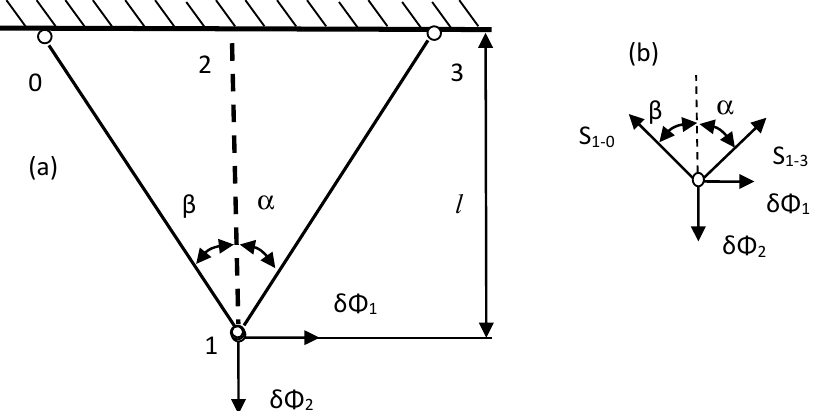
Figure 5. Three-rod system without the middle bar removed: ( a ) design model and ( b ) node 1.